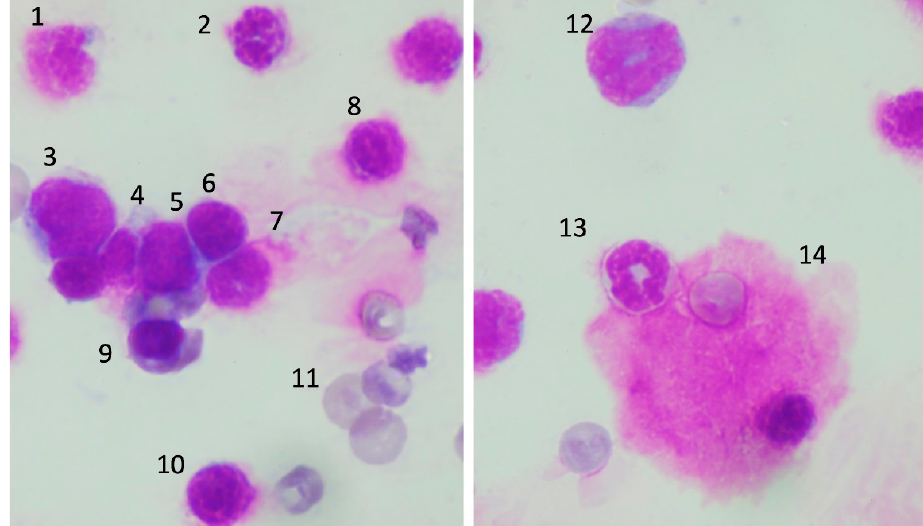
Figure 6. Bone marrow smear in the sublethal model of heatstroke. Bone marrow cells were less damaged in the sublethal model of heatstroke. 1: lymphocyte, 2: neutrophilic band cell, 3: promonocyte, 4–6: lymphocytes, 7: damaged neutrophilic band cell, 8: damaged cell, 9: erythroblast, 10: damaged lymphocyte, 11: reticulocyte, 12: myelocyte, 13: band cell, 14: megakaryocyte.